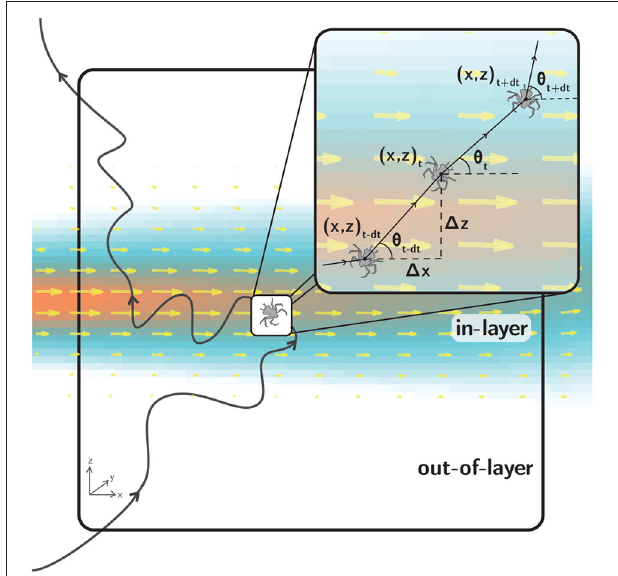
FIGURE 5 | A hypothetical larval swimming trajectory (black line) in the observation window (large black rectangle). The fluid shear layer is denoted by the velocity vectors (yellow) and velocity magnitude contours (orange to blue). The inset (small black rectangle) shows a detailed view of kinematic parameters used to quantify swimming behavior during shear layer assays. The two-dimensional swimming trajectory projections are characterized by larval positions at each time step [ x ( t ), z ( t )] and displacement vectors of varying magnitude with directional headings θ ( t ) relative to the bulk flow direction.